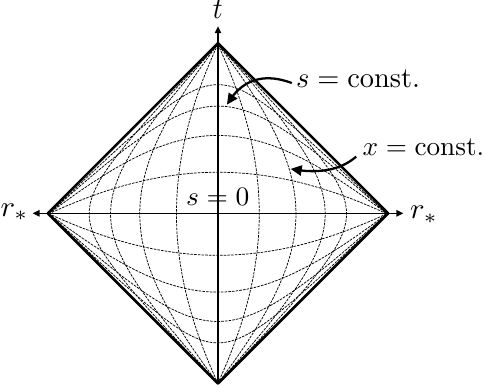
Figure 2: The ( x , s ) coordinate chart of a maximally symmetric causal diamond. The co- ordinate s ∈ ( −∞ , ∞ ) is the conformal Killing time, defined as the function that vanishes on the maximal slice Σ and satisfies ζ · ds = 1. The coordinate x ∈ [ 0, ∞ ) is spherically symmetric and satisfies ζ · dx = 0 and | dx | = | ds | . Constant s and x lines are plotted at equal coordinate intervals of 0.5. See Appendix B for a demonstration that ds and dx are everywhere orthogonal, and for the line element in these